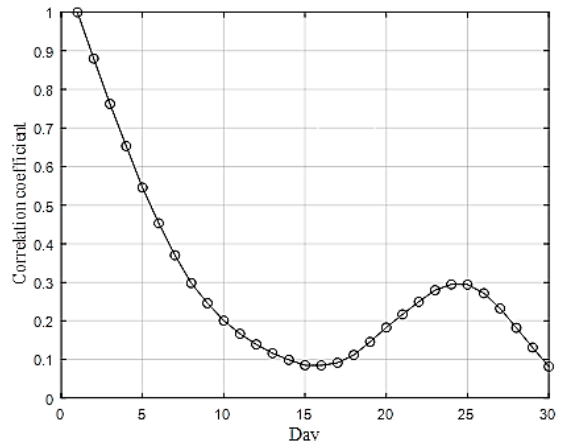
Figure 4. Correlation coefficient between current and previous days.